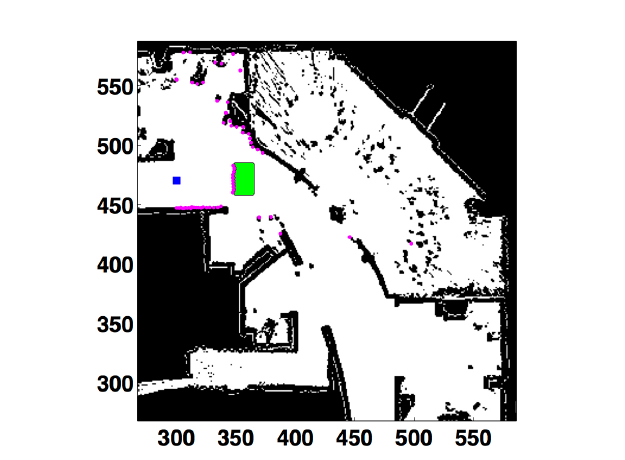
Figure 10. Obstacle produces an occlusion in front of the robot. All units in cells. Laser readings in purple. Robot’s location in the blue square. Unmodeled obstacle in green.